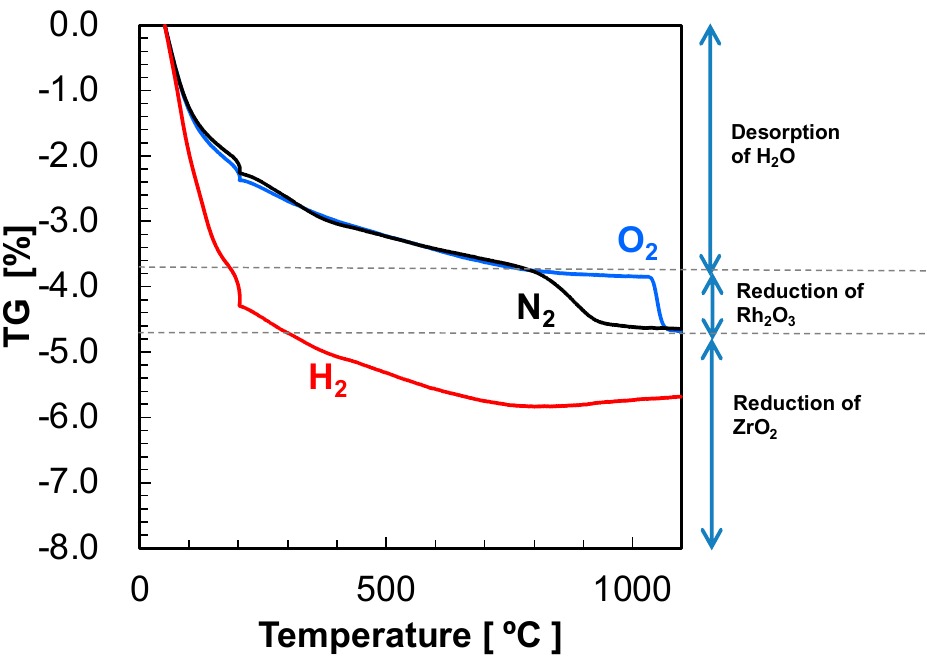
Figure 7. DTA − TG measurement results for Rh/ZrO 2 in O 2 , N 2 , and H 2 .